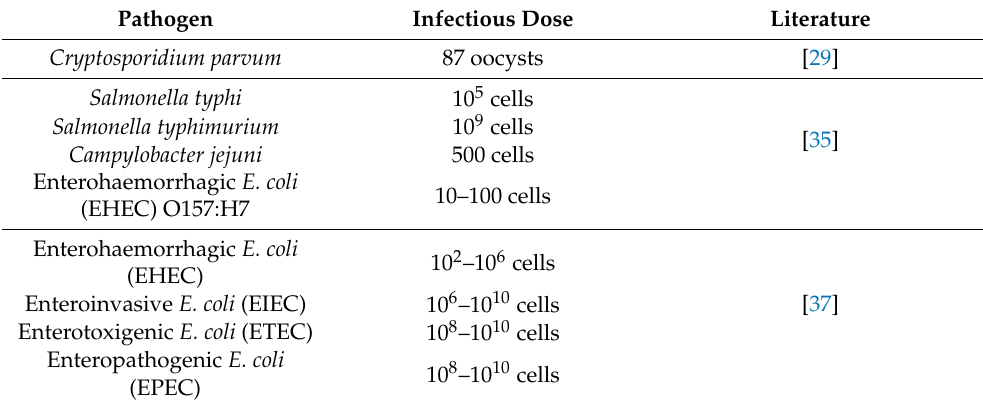
Table 2. Infectious doses of pathogens on the basis of literature data. Pathogen Infectious Dose